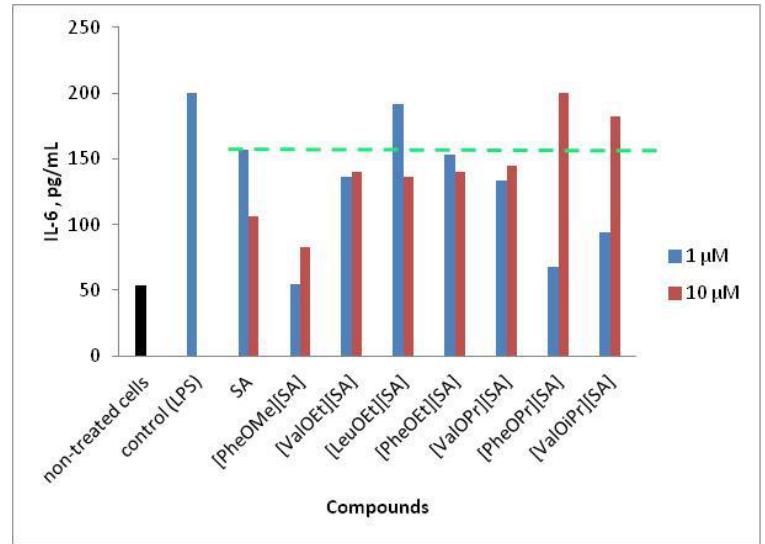
Figure 1. Cytokine levels in the supernatant of LPS-stimulated HaCaT cells were non-treated and treated with 1 or 10 µM [AAOR][SA] or SA.